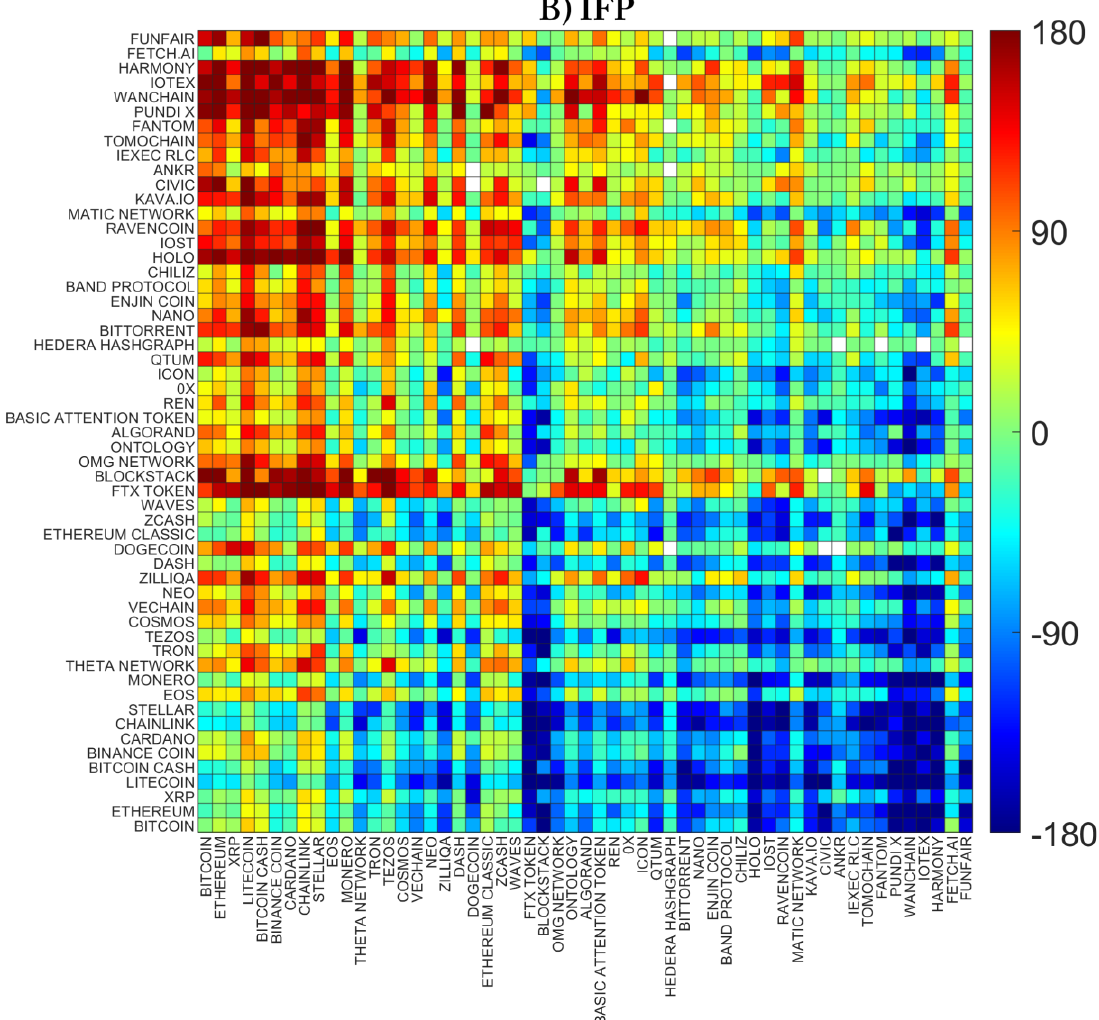
Fig. 2B. Mean pairwise iso-frequency coupling phase (IFP). Each pixel value corresponds to the mean of the phases of all significant IFC values for each pair of cryptocurrencies. Phase values are in degrees and range from -180 to